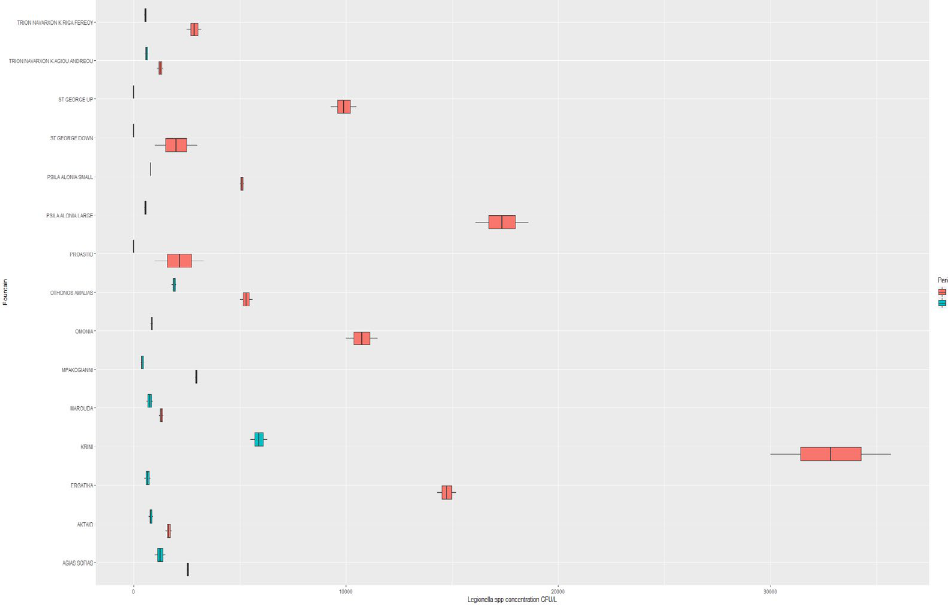
Figure 2. Legionella spp. concentrations (on a logarithmic scale) for each fountain per period.